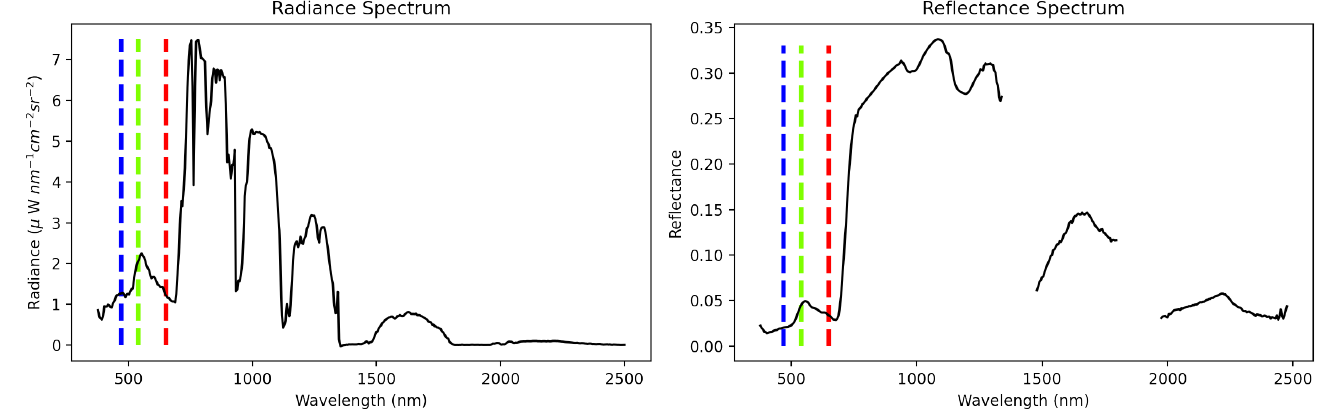
Figure 1. Representative radiance and reflectance spectra. Red, green, and blue lines indicate visible color